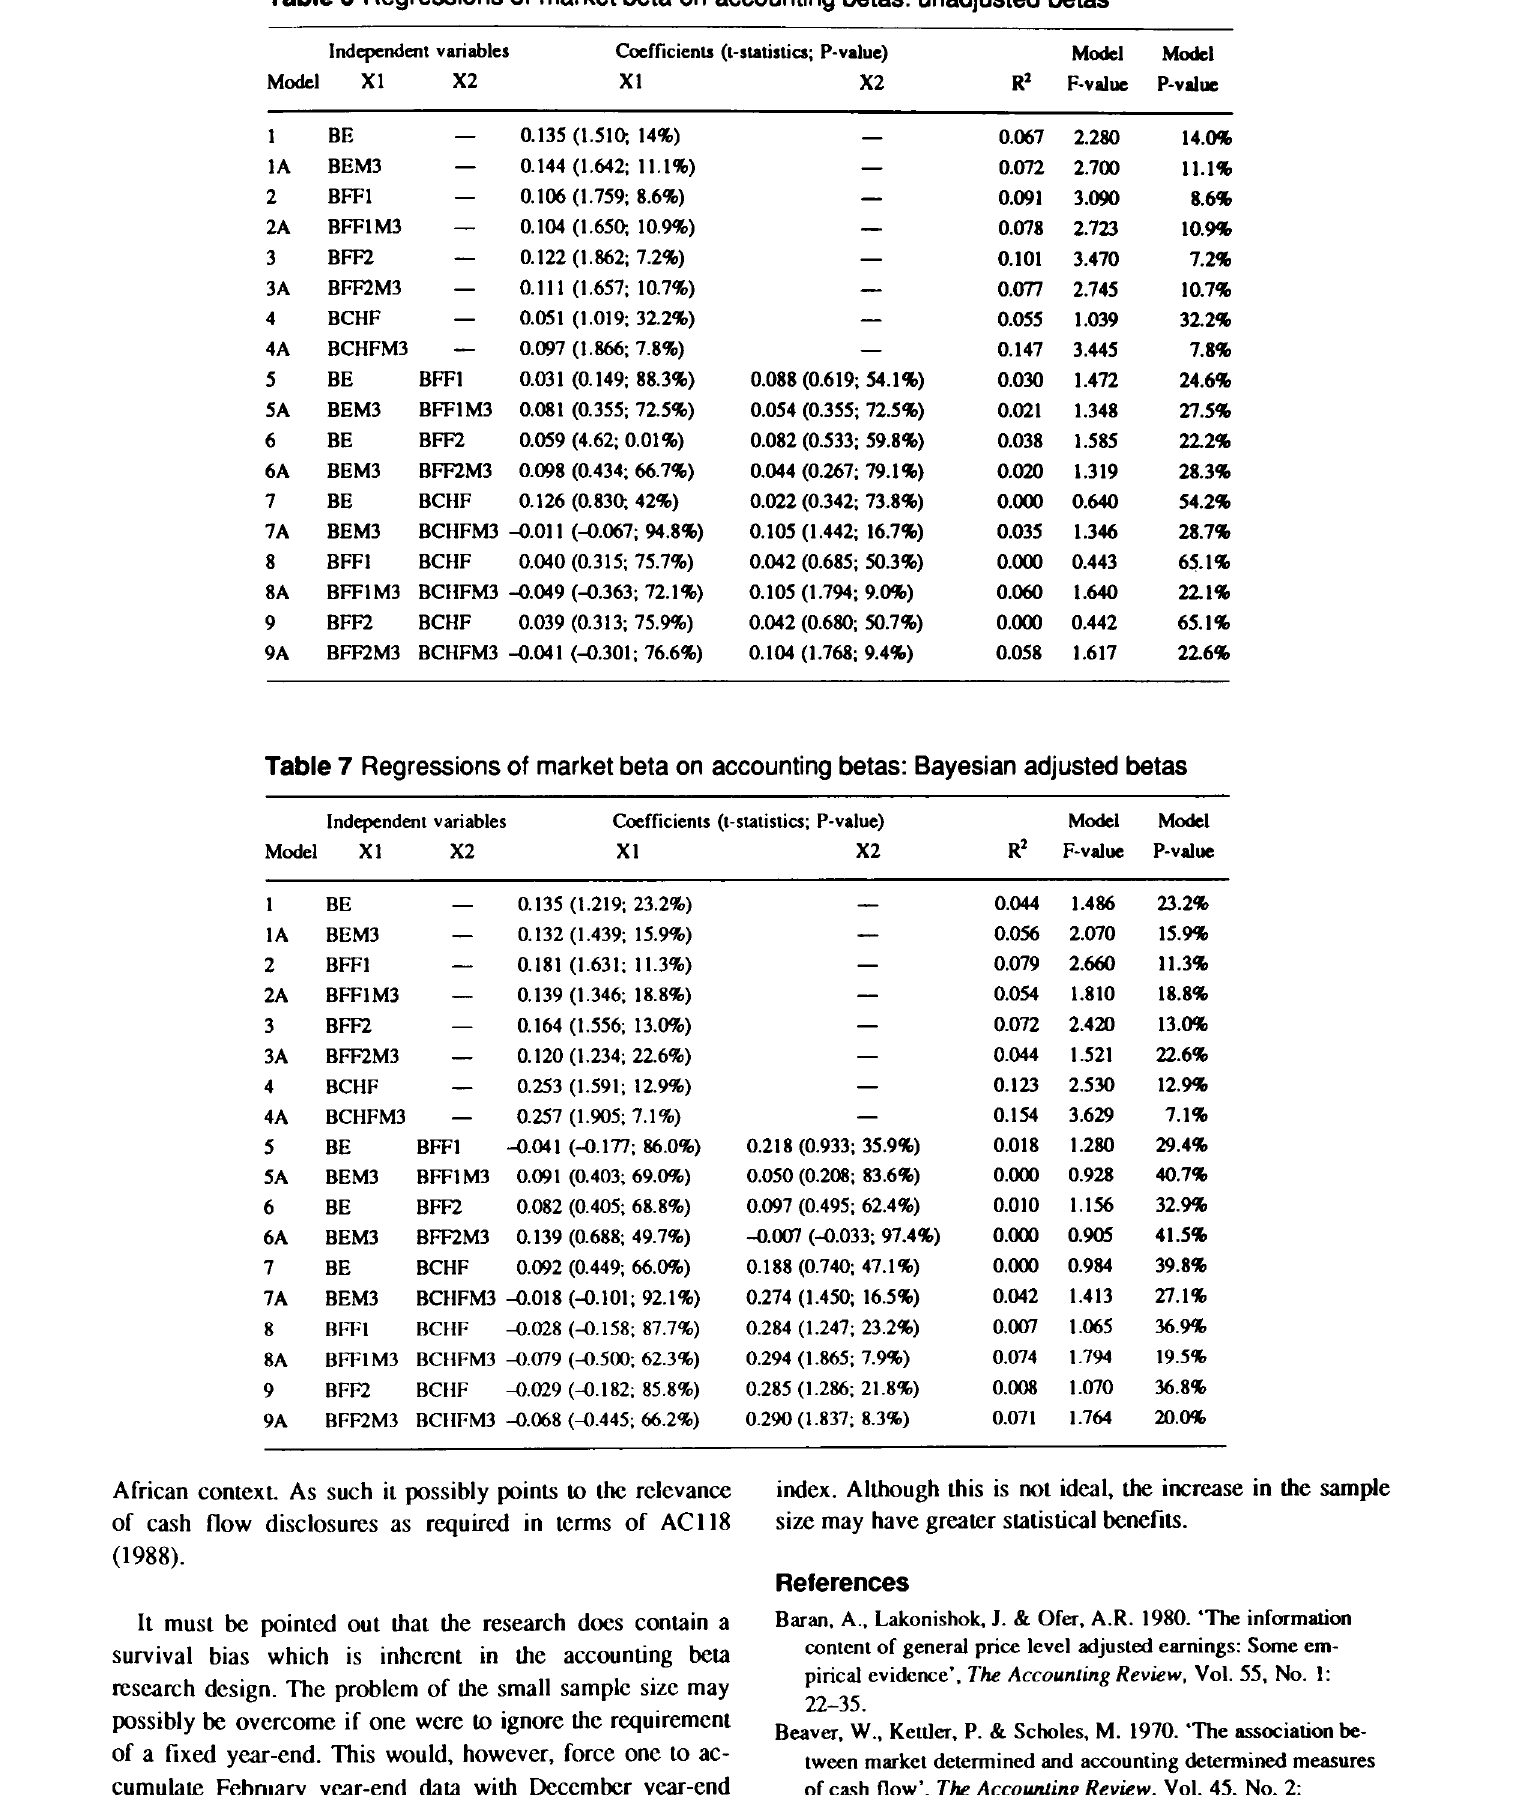
Table 7 Regressions of market beta on accounting betas: Bayesian adjusted